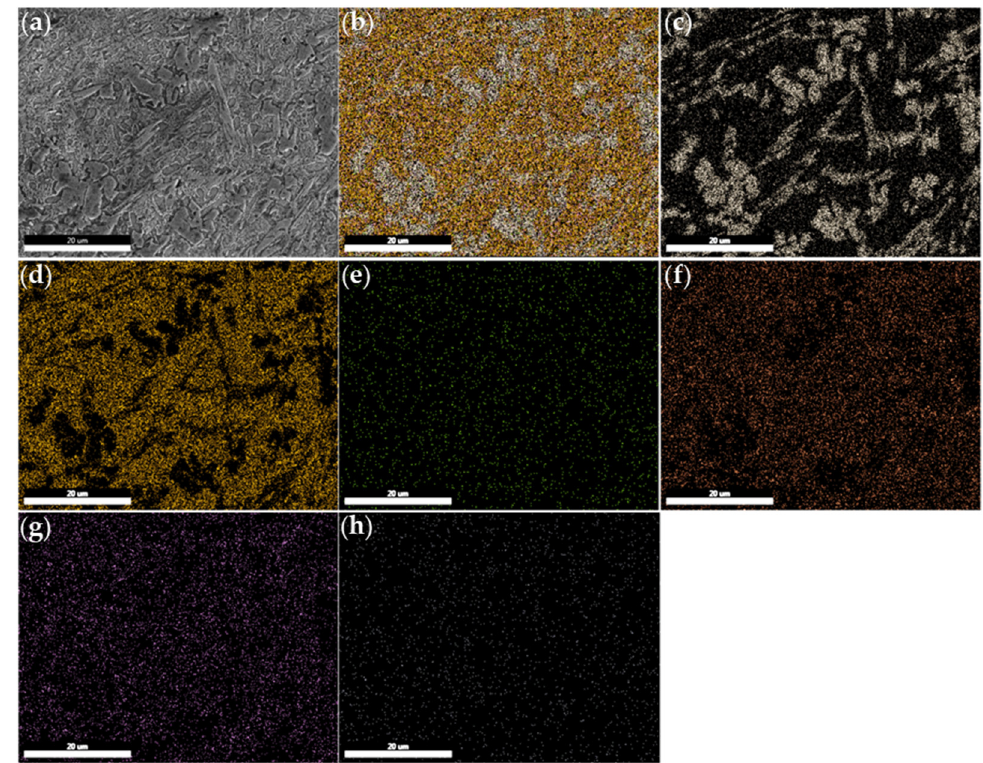
Figure 15. EDS mapping results of the Ni60PTA coating. ( a ) Morphologies of selected regions; ( b ) overall elements; ( c ) Cr; ( d ) Ni; ( e ) C; ( f ) Fe; ( g ) Si; ( h ) B.